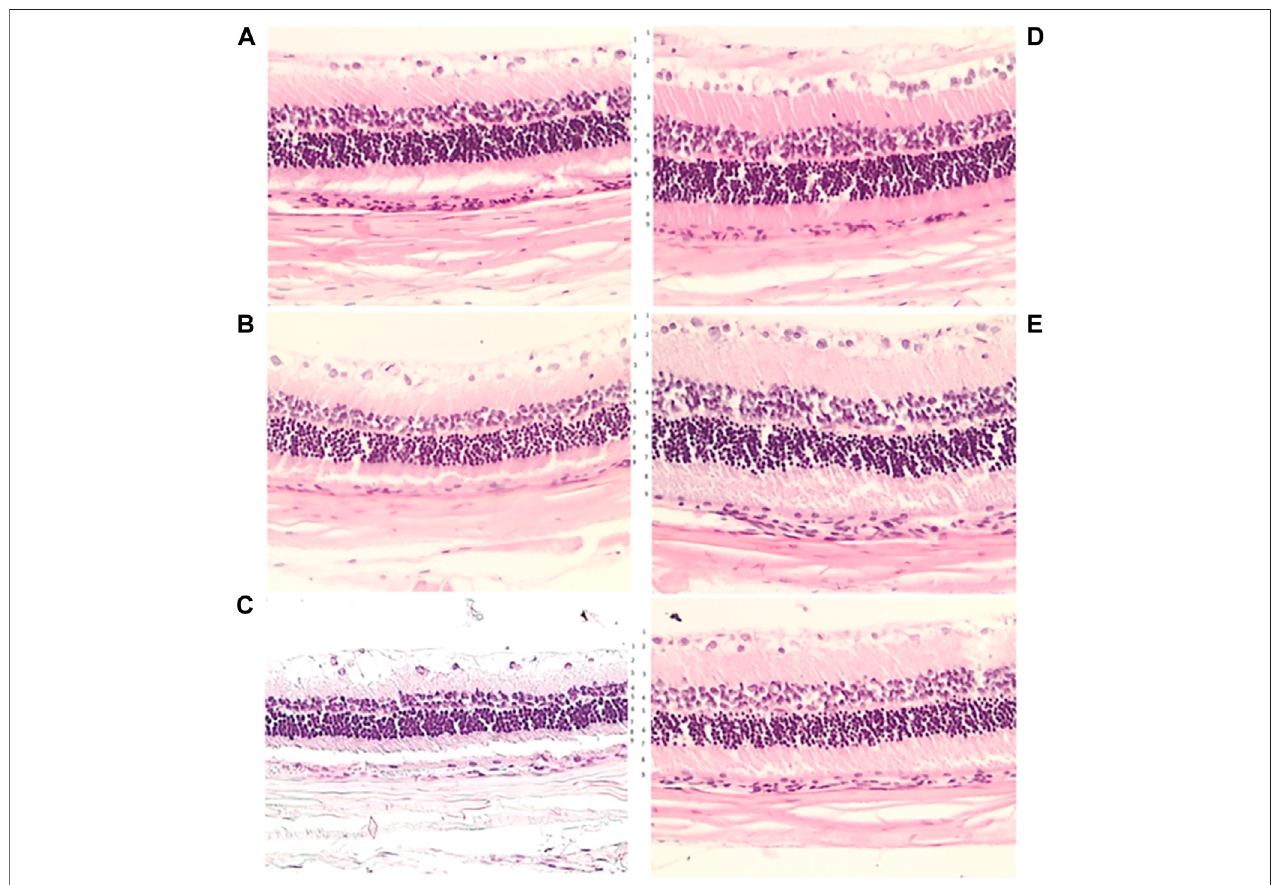
FIGURE7| Microscopicpresentation oftherat retinaat week1 (A) ,week 2 (B) and week 4 (C) after L-NAMEretrobulbarapplication,in controls (D) and BPC157 treatedrats (E) ,HE,x20.Transversesection oftheretina(0.4 – 0.7 mm onthetemporalsideoftheopticdisc)showingastrict difference inthe retinal layersand fullretina thickness in the rats underwent L-NAME that received retrobulbar saline application and those that received BPC 157. More regular inner and outer nuclear layer and moreregular distribution ofganglioncells,preservedthickness oftheretina,theinnerplexiformlayerandinner nuclearlayeratweek1 (A,E) .More regularinnerand outernuclearlayerandmoreregulardistributionofganglioncells,preservedthicknessoftheretina,theinnerplexiformlayerandinnernuclearlayeratweek2 (B,E) (more regular inner and outer nuclear layer and more regular distribution of ganglion cells, preserved thickness of retina, the inner plexiform layer and inner nuclear layer). At week 4, BPC 157 treated rats show the preserved thickness of the whole retina, also inner plexiform layer and inner nuclear layer (C,E) . Contrarily, degeneration of ganglion cells in control group is the most evident (C,D) . Also, the outer nuclear layer is more regular in BPC 157 treated rats. 1 — internal limiting membrane; 2 — nerve fi ber and ganglion cell layers; 3 — inner plexiform layer; 4 — inner nuclear layer; 5 — outer plexiform layer; 6 — outer nuclear layer; 7 — outer limiting membrane; 8 — photoreceptor layer; 9 — pigment epithelium.